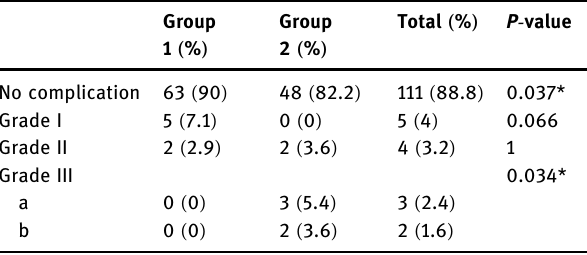
Table 4: Postoperative complications according to